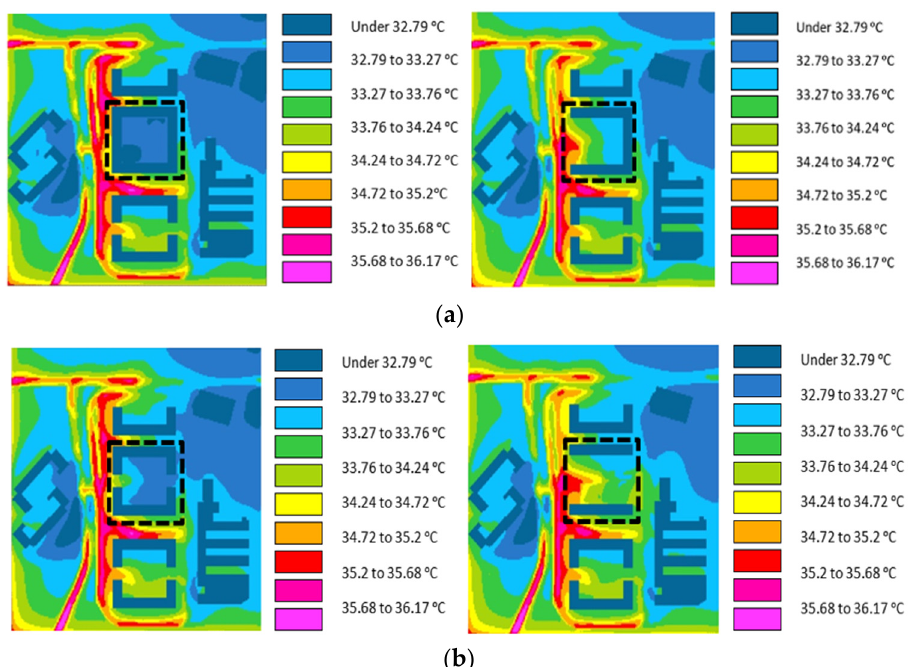
Figure 14. ( a ) Predicted air temperature bands at 0 m above the ground level at 4 p.m. in the FBTS models (Left—courtyard; Right—U model). ( b ) Predicted air temperature bands at 0 m above the ground level at 4 p.m. in the FBTS models (Left—courtyard canyon; Right—canyon).